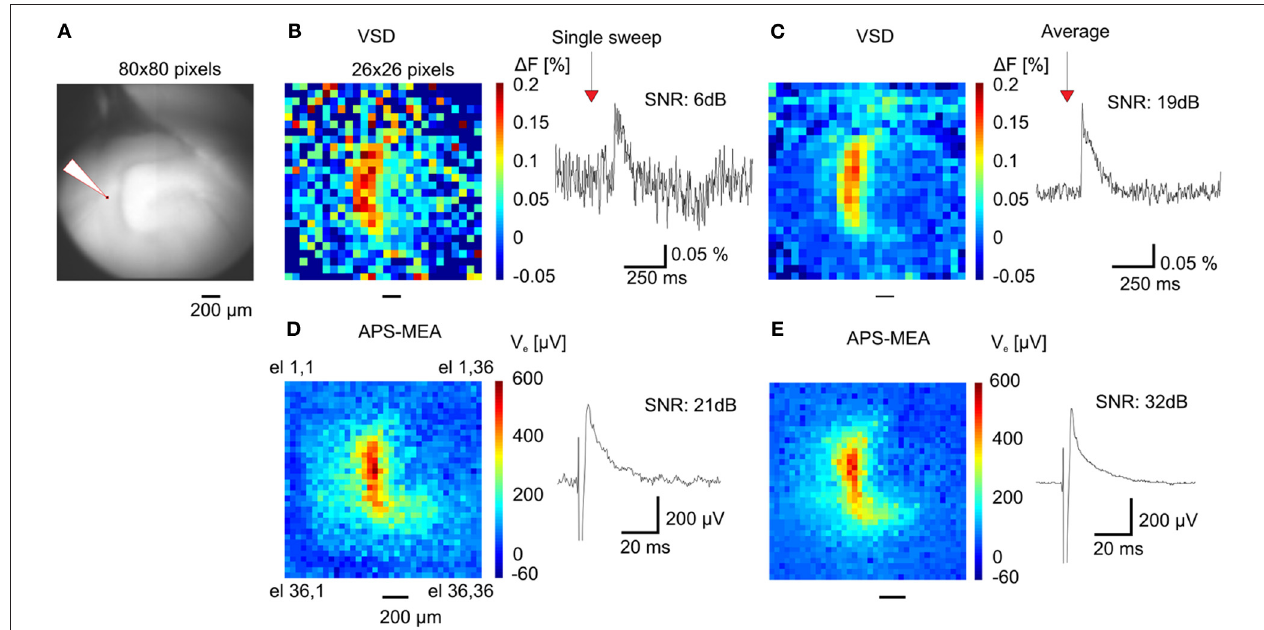
electrical stimulation (left) and averaged single pixel trace (right). (D) Color-coded voltage image showing the peak amplitude of the APS-MEA electrodes after the same electrical stimulation (left) and single electrode voltage trace (right). To compare with VSD recordings, (1) an equivalent field of view is shown by cropping the full array recording, (2) the voltage trace is inverted. (E) Color-coded voltage image showing the averaged peak amplitude of 5 responses after electrical stimulation (left) and averaged single electrode voltage trace